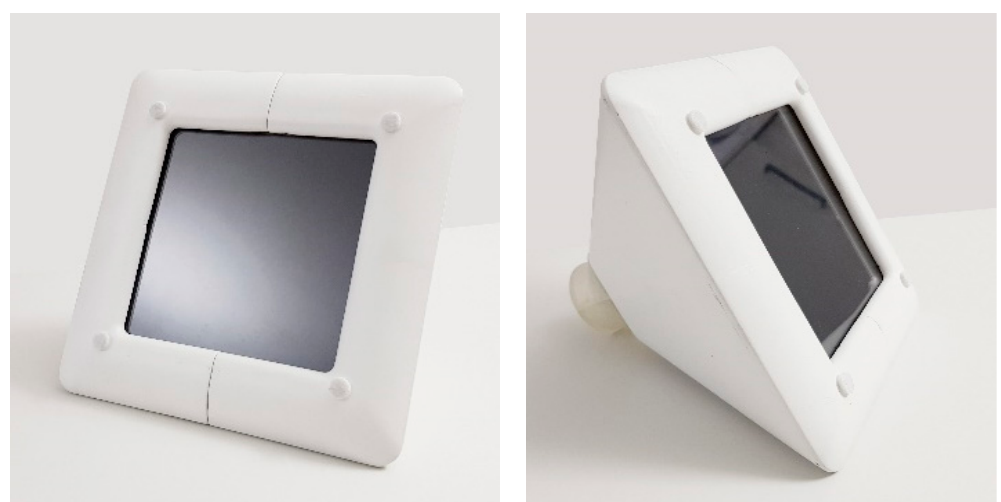
Figure 5 . Functionality of the “Pyramid”.